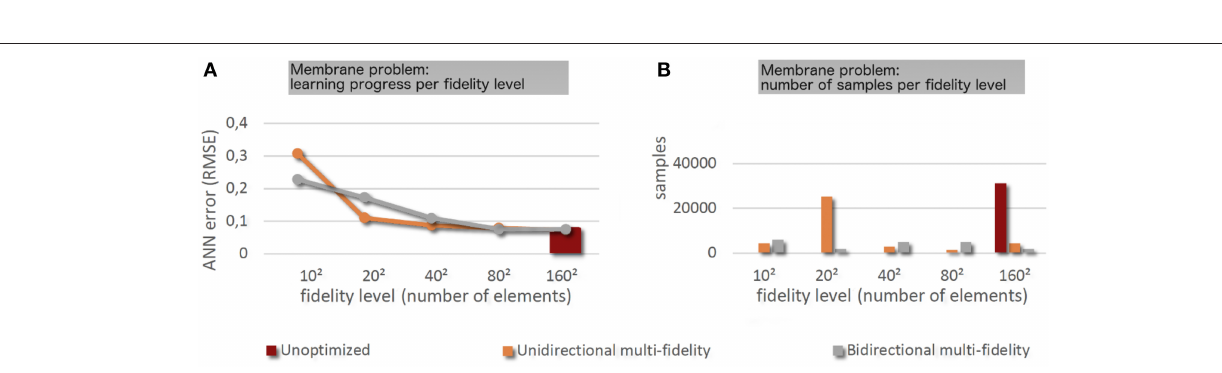
FIGURE 6 | (A) Learning progress across the different fidelity levels for the different training strategies. (B) Number of samples used per fidelity level for the different training strategies.